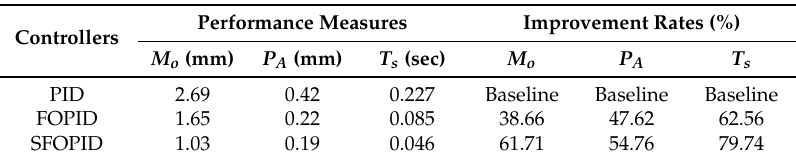
Figure 11. Step responses of the VCM control system using the PID, FOPID, and SFOPID controllers: ( a ) complete step responses; ( b ) first two step responses. Table 3. Performance measures and improvement rates for the continuous step responses of various VCM control systems.